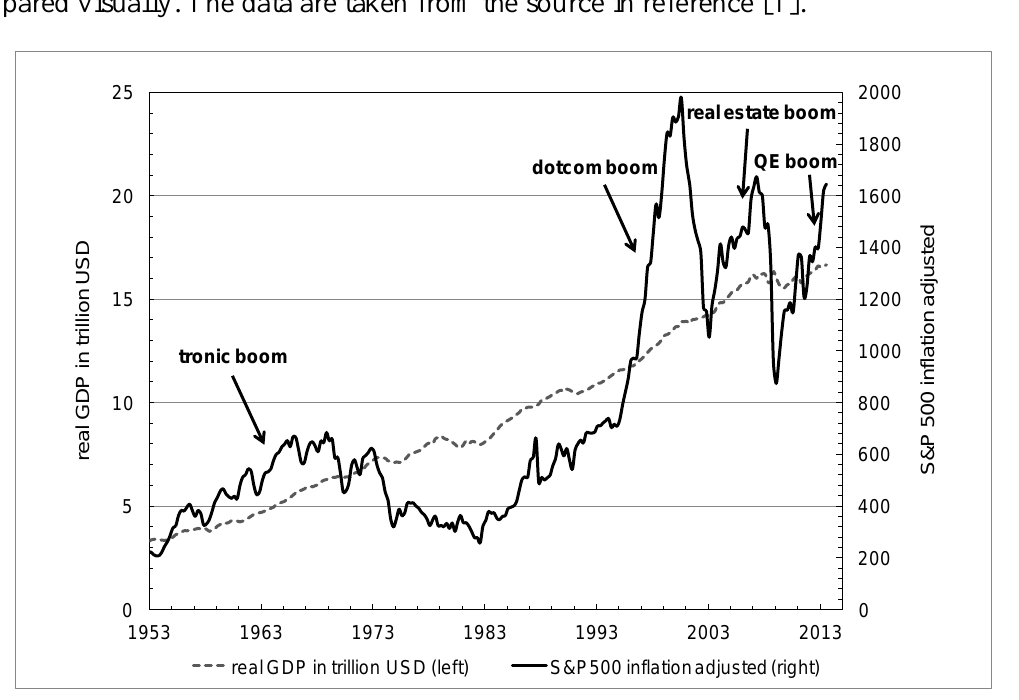
Figure 1. Real GDP in 2013 U.S. dollars (dashed line) compared with real stock market value (continuous line) proxied by the S&P500 stock index from 1953 to Q3 2013. The left and right vertical scales respect ratios so that the growth rates of GDP and S&P500 can be compared visually. The data are taken from the source in reference